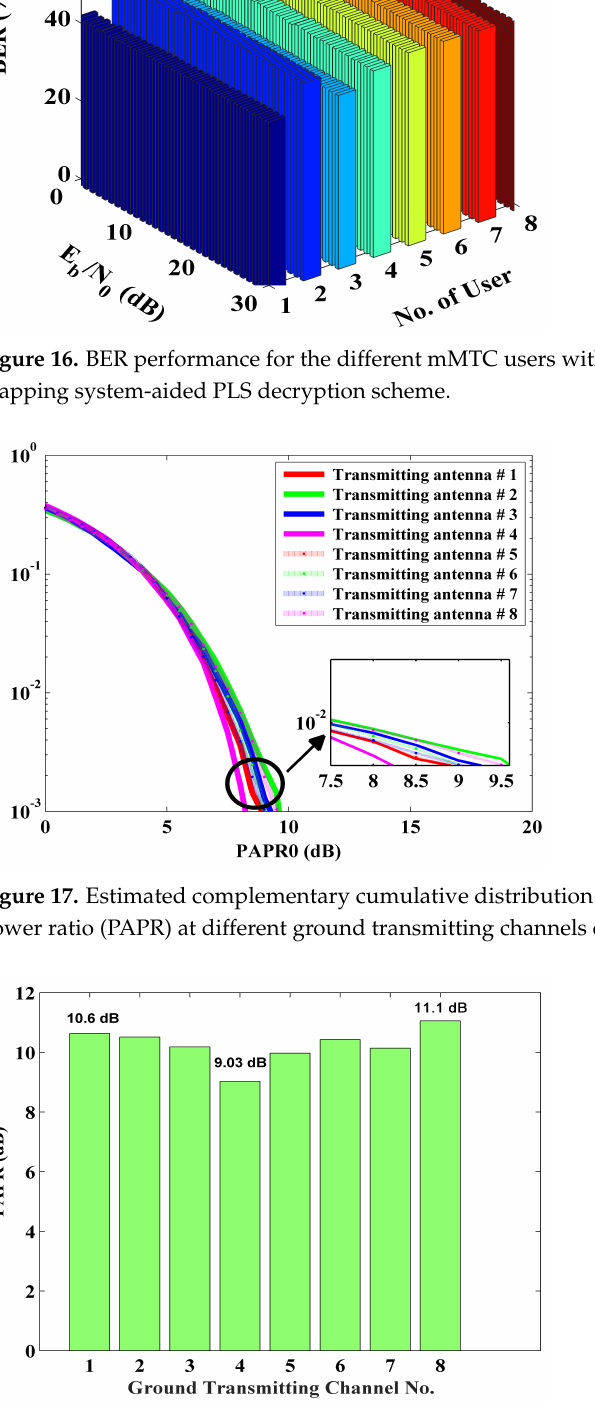
Figure 18. Estimated peak-to-average power ratio (PAPR) at different ground transmitting channels of the proposed simulated